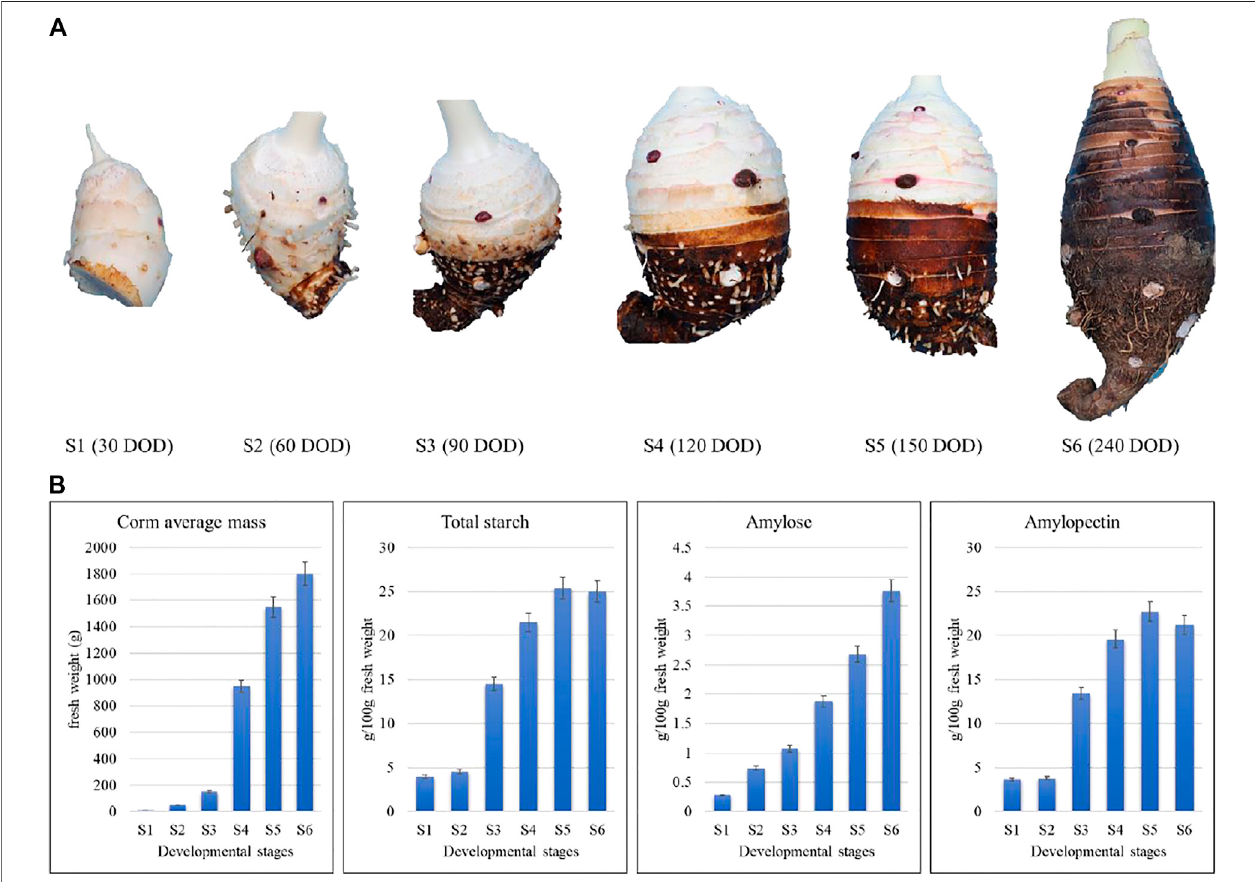
FIGURE 1 | Morpho-biochemical comparison of taro corms based on growth stage and starch contents. S1, S2, S3, S4, S5, and S6 refer to the corm samples harvested after 1, 2, 3, 4, 5, and 8 months.